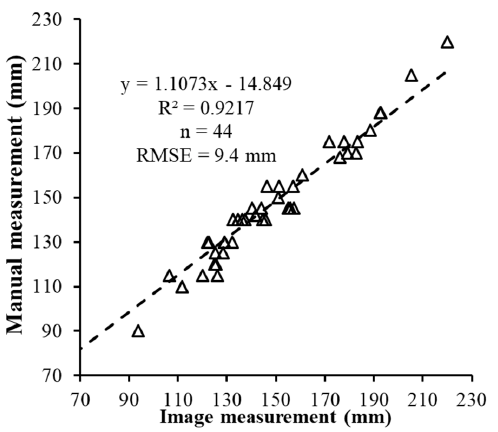
Figure 9. The agreement of image measurements and manual measurements in plant height. Table 6. ANOVA test results of the comparison of image measurements with manual measurements. Degree of Freedom Sum of Squares Mean Square F Value Pr (> F )